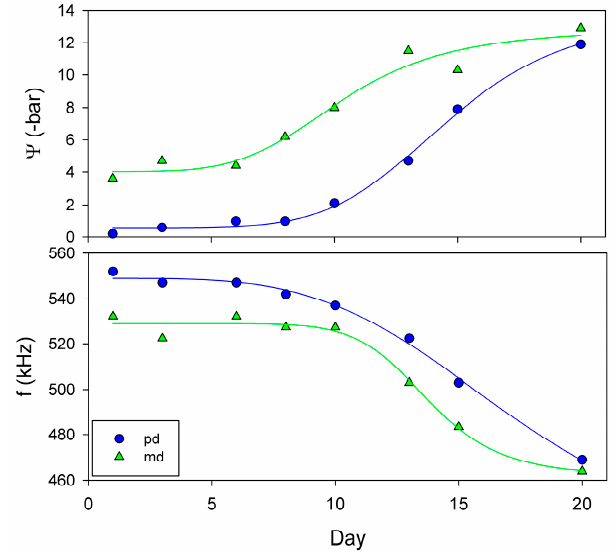
Figure 12. Evolution of Ψ and f res (f) to drought for a single leaf of Vitis vinifera cv. Grenache (circle) measured at predawn (pd, circle) and midday (md, triangle) along the water stress experiment.